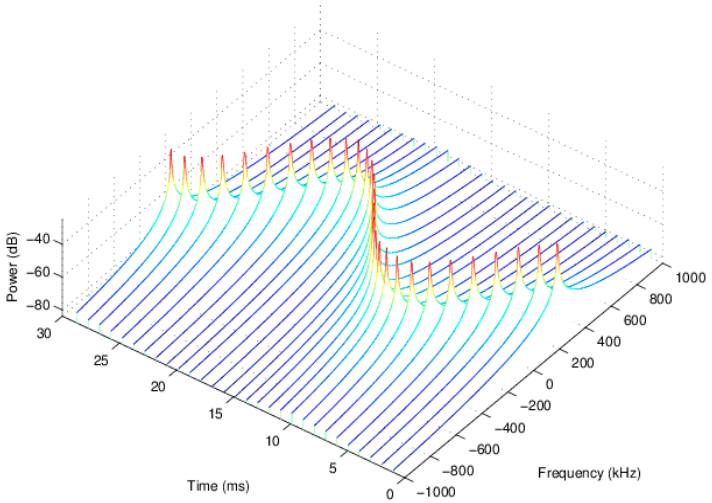
Figure 10. The waterfall graph of all 29 NMR spectra.